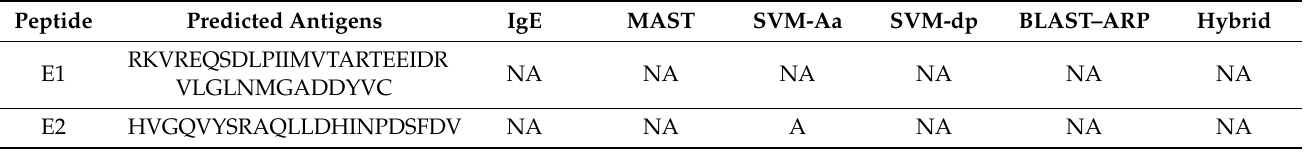
Table 3. Allergenicity predictions for the BaeR epitopes (SVM and hybrid approaches at threshold value 0.4) using